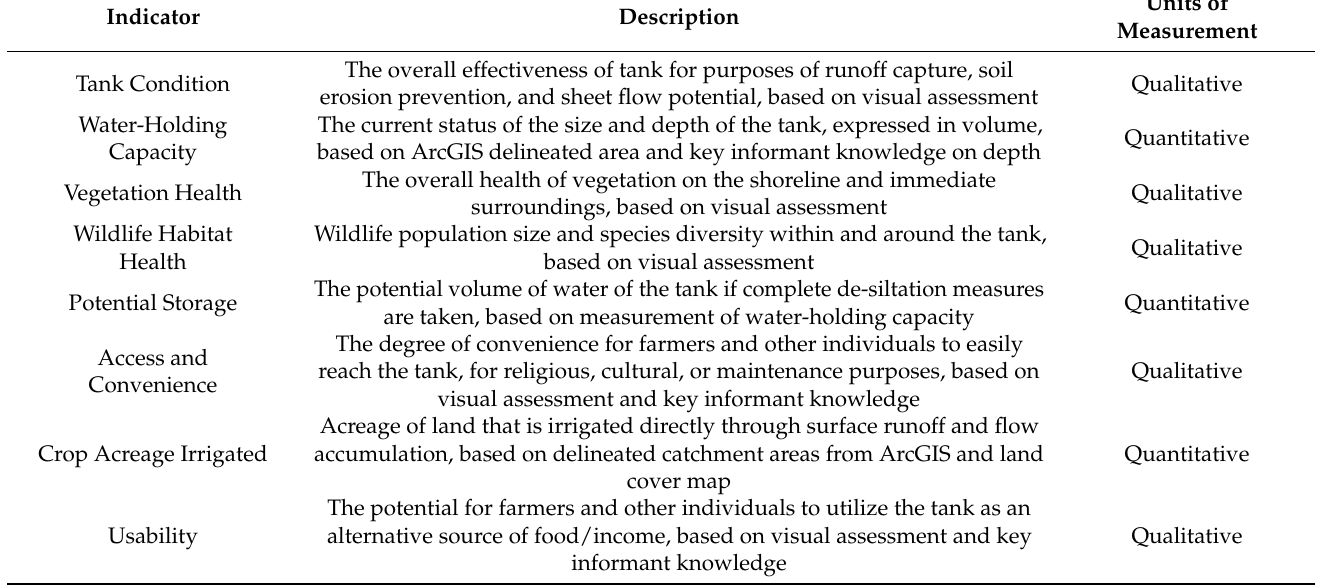
Table 1. Multi-attribute indicators that influence tank